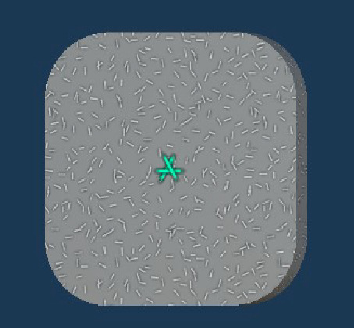
Figure 1. An example of NeuroTag and its flickering